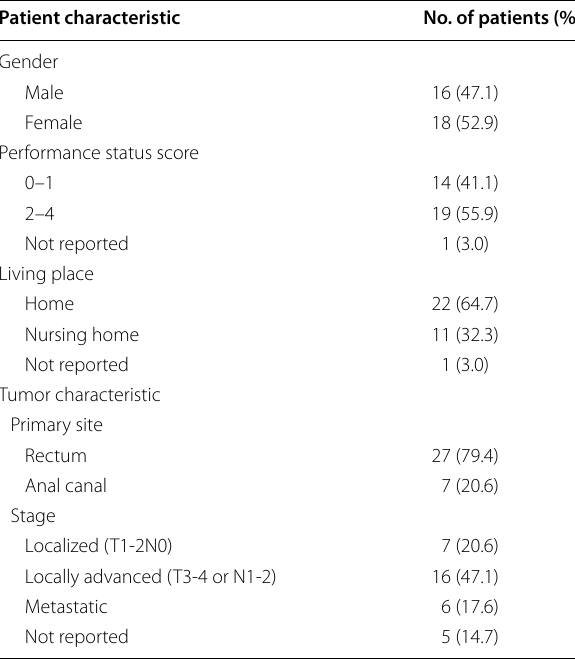
Table 1 Characteristics of 34 nonagenarians undergoing radiotherapy for anal or rectal carcinoma Patient